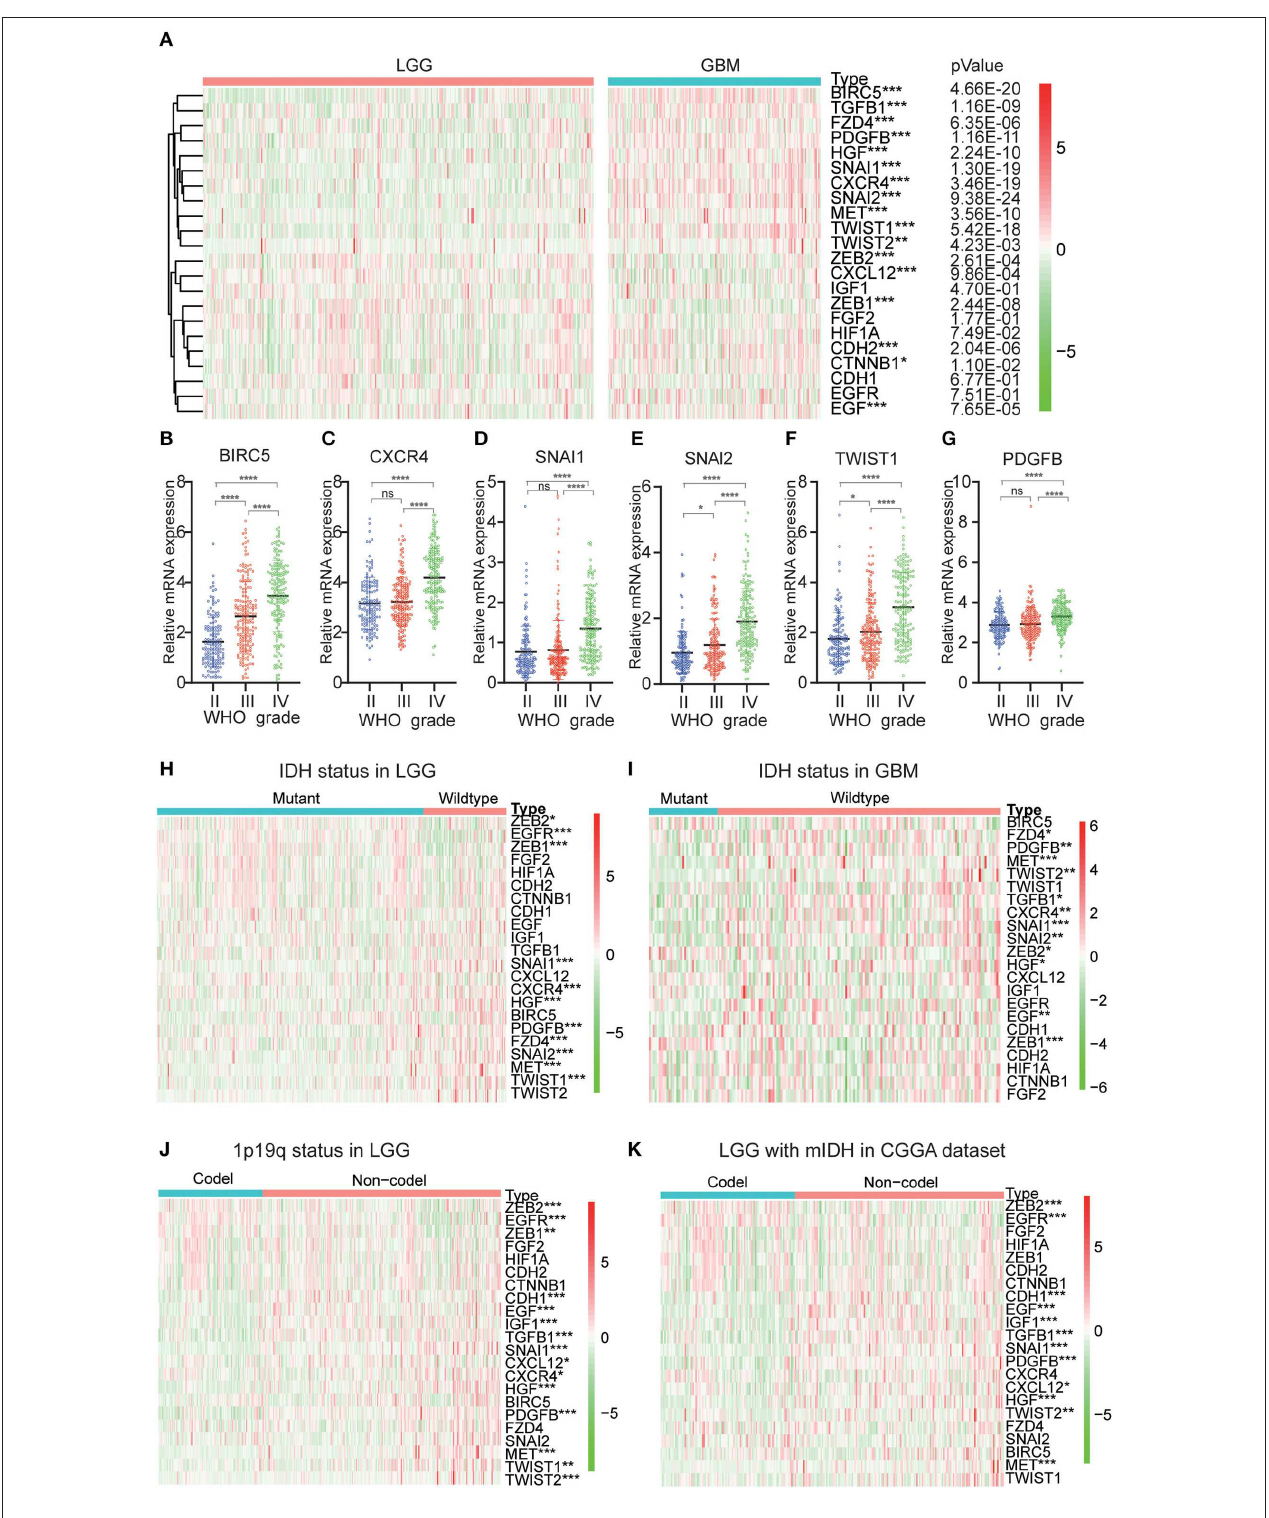
FIGURE 1 | Expression of EMT related genes in gliomas with different clinicopathological features. (A–G) The expression levels of 22 EMT related genes in gliomas with different WHO grades. (H,I) The expression levels of EMT related genes in LGG and GBM with different IDH status. (J) The expression levels of EMT related genes in LGG with different 1p/19q codeletion status. (K) The expression levels of EMT related genes in IDH-mutant (mIDH) LGG with different 1p/19q codeletion status. * P < 0.05, ** P < 0.01, *** P < 0.001 and **** P < 0.0001.